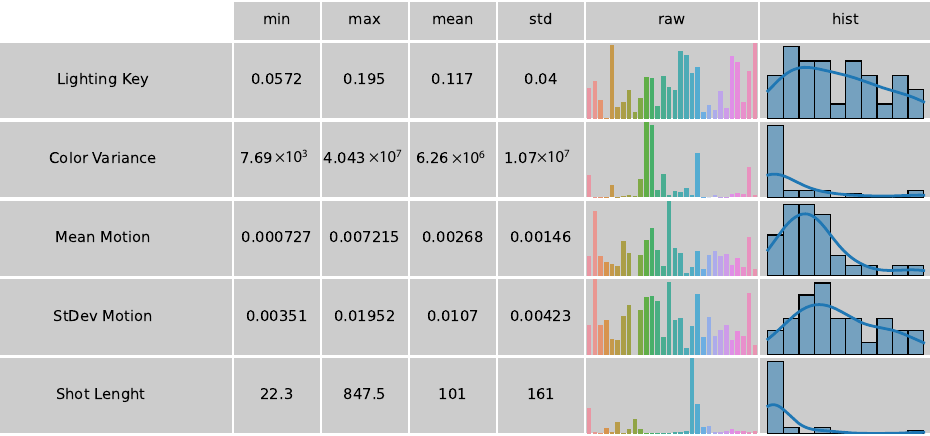
Figure 1. Basic statistics for low-level video features derived from the ads. The table columns represent the minimum, maximum, mean, and standard deviation for each video feature, respectively. The last two columns show the randomized bar graph of raw consecutive feature values for each ad and their